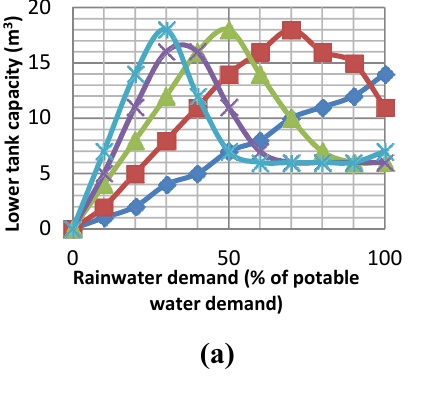
Figure 16. Rainwater tank capacity as a function of rainwater demand, catchment surface area, and number of people per house in Darwin, Australia. ( a ) 100 m 2 and two people; ( b ) 100 m 2 and four people; ( c ) 400 m 2 and two people; ( d ) 400 m 2 and four